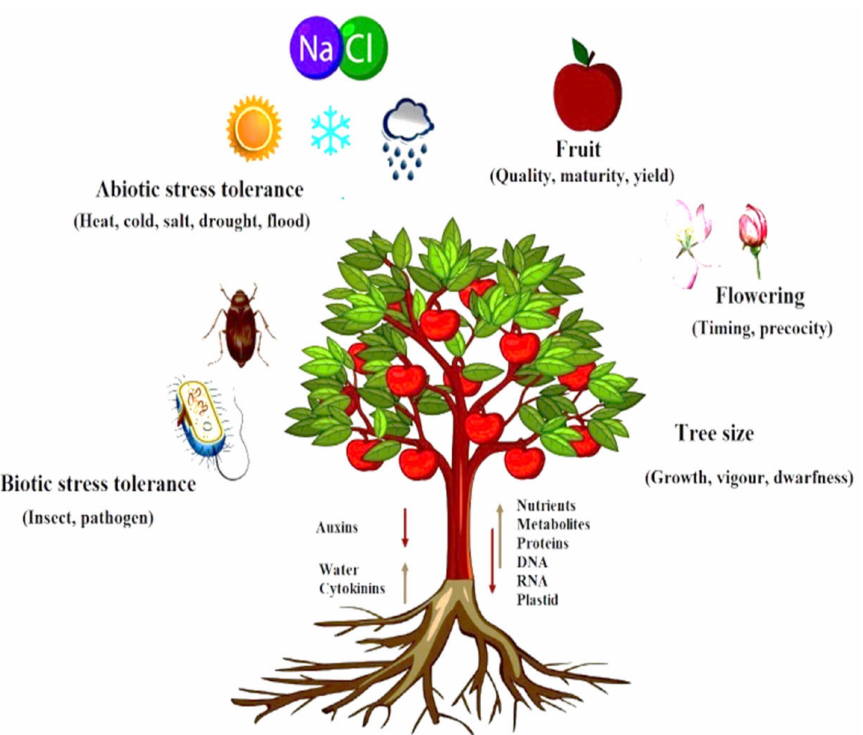
Figure 1. Macromolecules DNA, RNA, protein, hormones, and plastid DNA bidirectional movement via graft union explain the role of molecular and hormone signaling and also explain the effect of scion–rootstock relationship on quality fruit